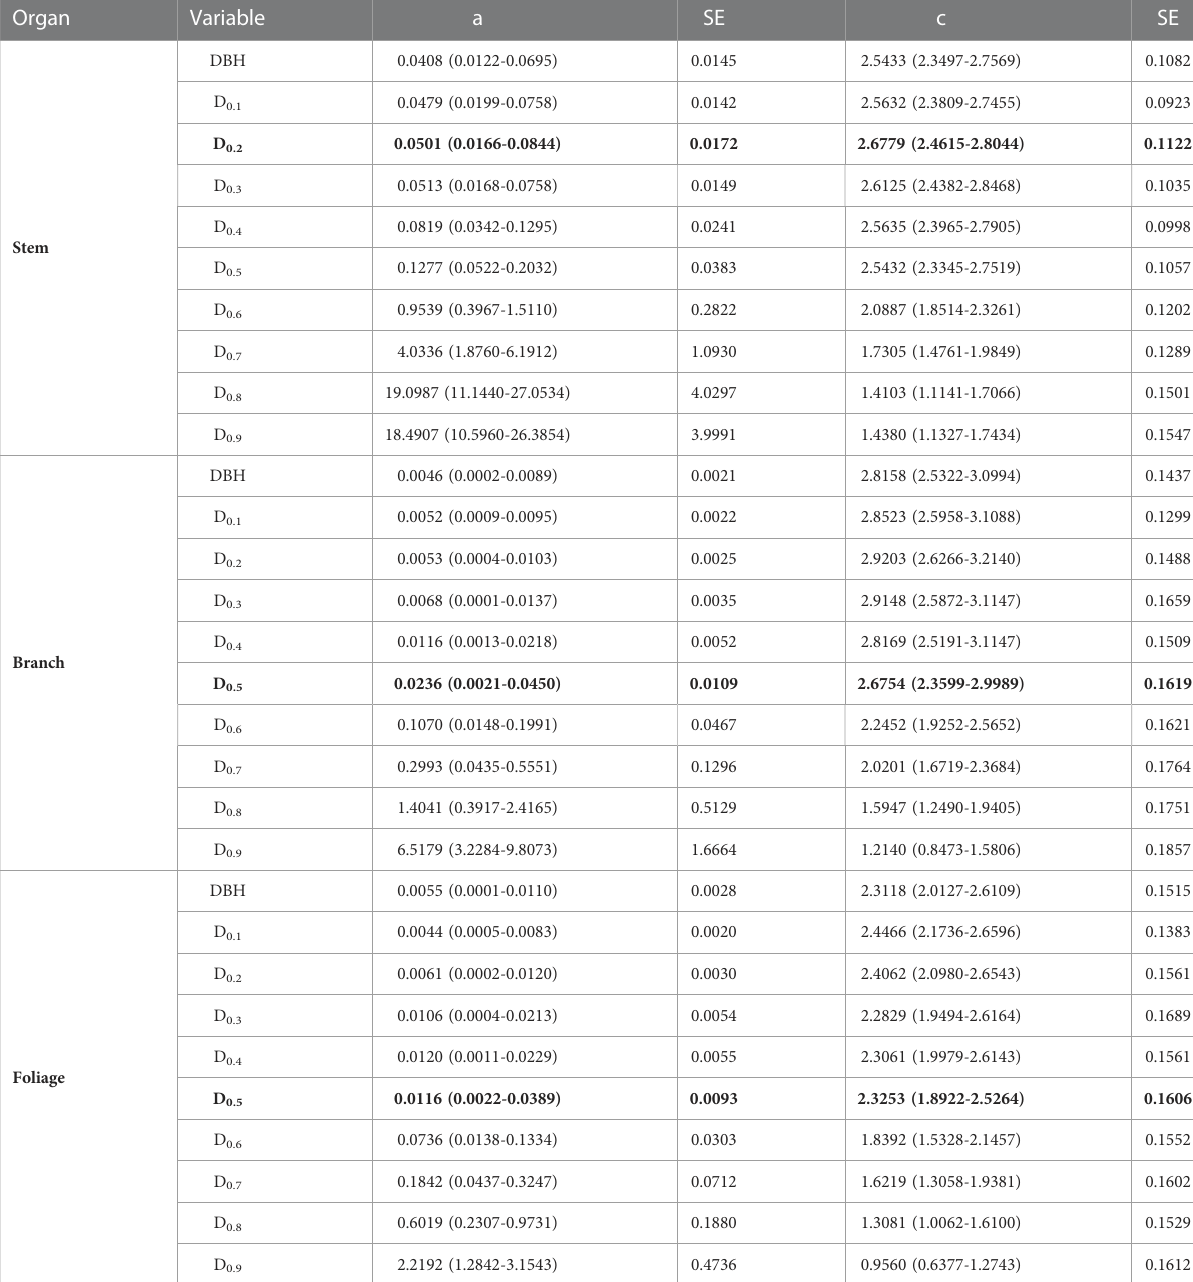
TABLE 4 Coef fi cient estimates for the biomass equations based on the DBH and diameter in relative tree height.